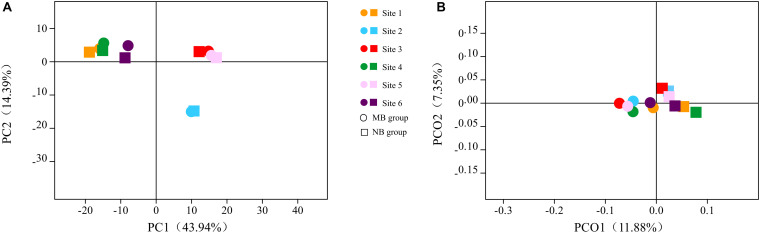
The (A) principal component analysis (PCA) and (B) principle coordinate analysis (PCoA) based on unweighted UniFrac analysis of six oral samples in two groups.